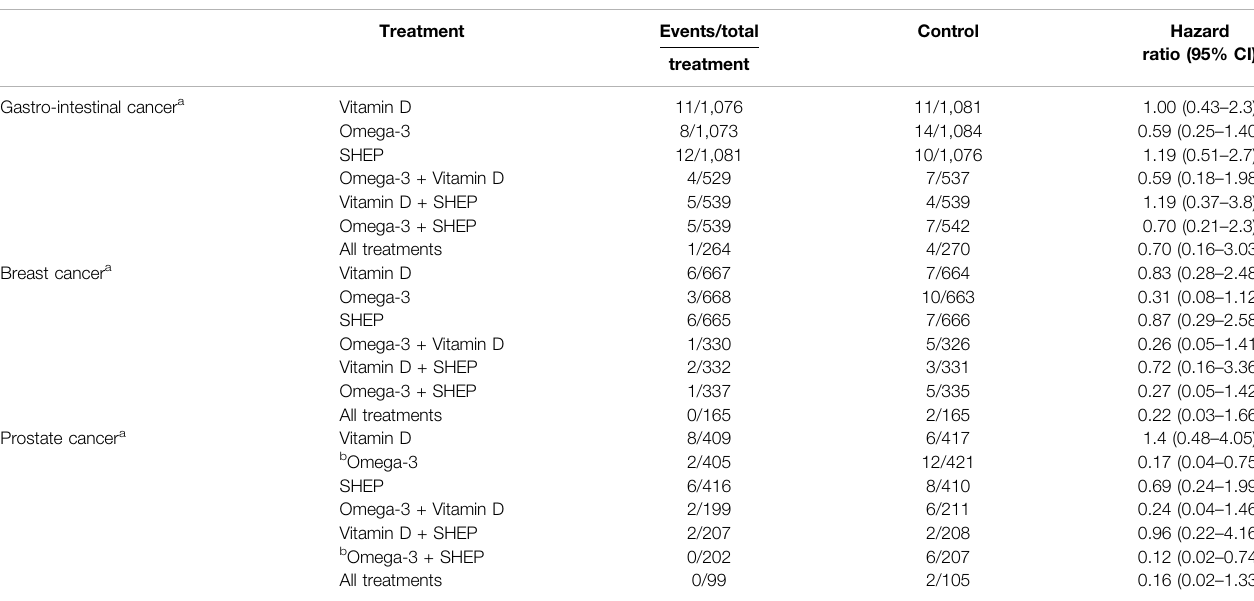
TABLE 2 | Secondary endpoints: individual